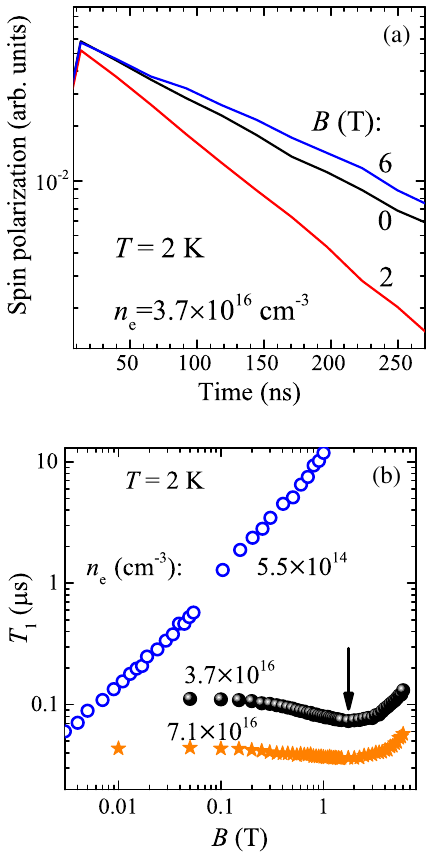
FIG. 1. Longitudinal spin relaxation. (a) Dynamics of the electron spin polarization (measured as Faraday rotation signal) at different magnetic fields for the n -GaAs sample with 3 . 7 × 10 16 cm − 3 . (b) Magnetic field dependence of the n e ¼ longitudinal relaxation time T 1 for samples with different donor concentrations. The arrow indicates the minimum in the T 1 ð B Þ dependence. (a),(b) Temperature T ¼ 2